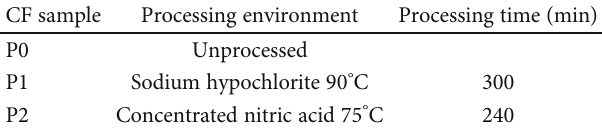
Table 4: Carbon fi ber surface treatment.